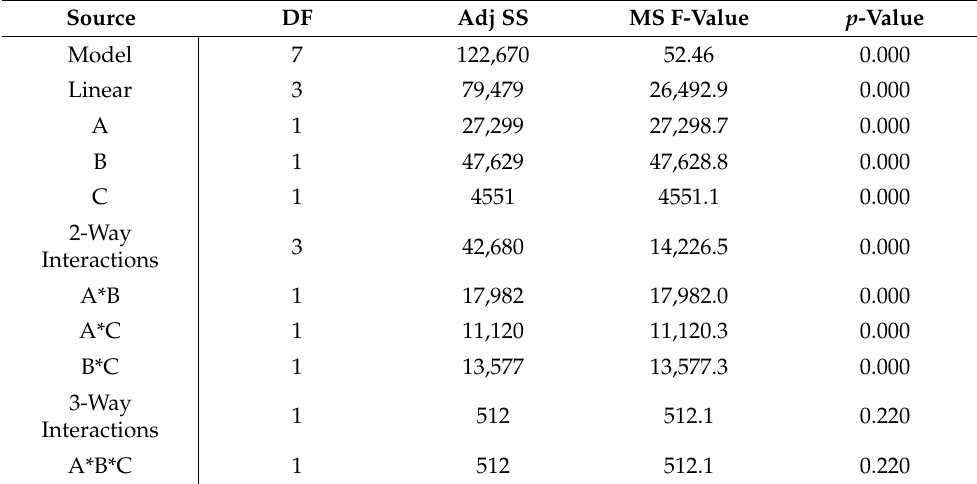
Table 8. Analysis of variance for factorial design of total evacuation